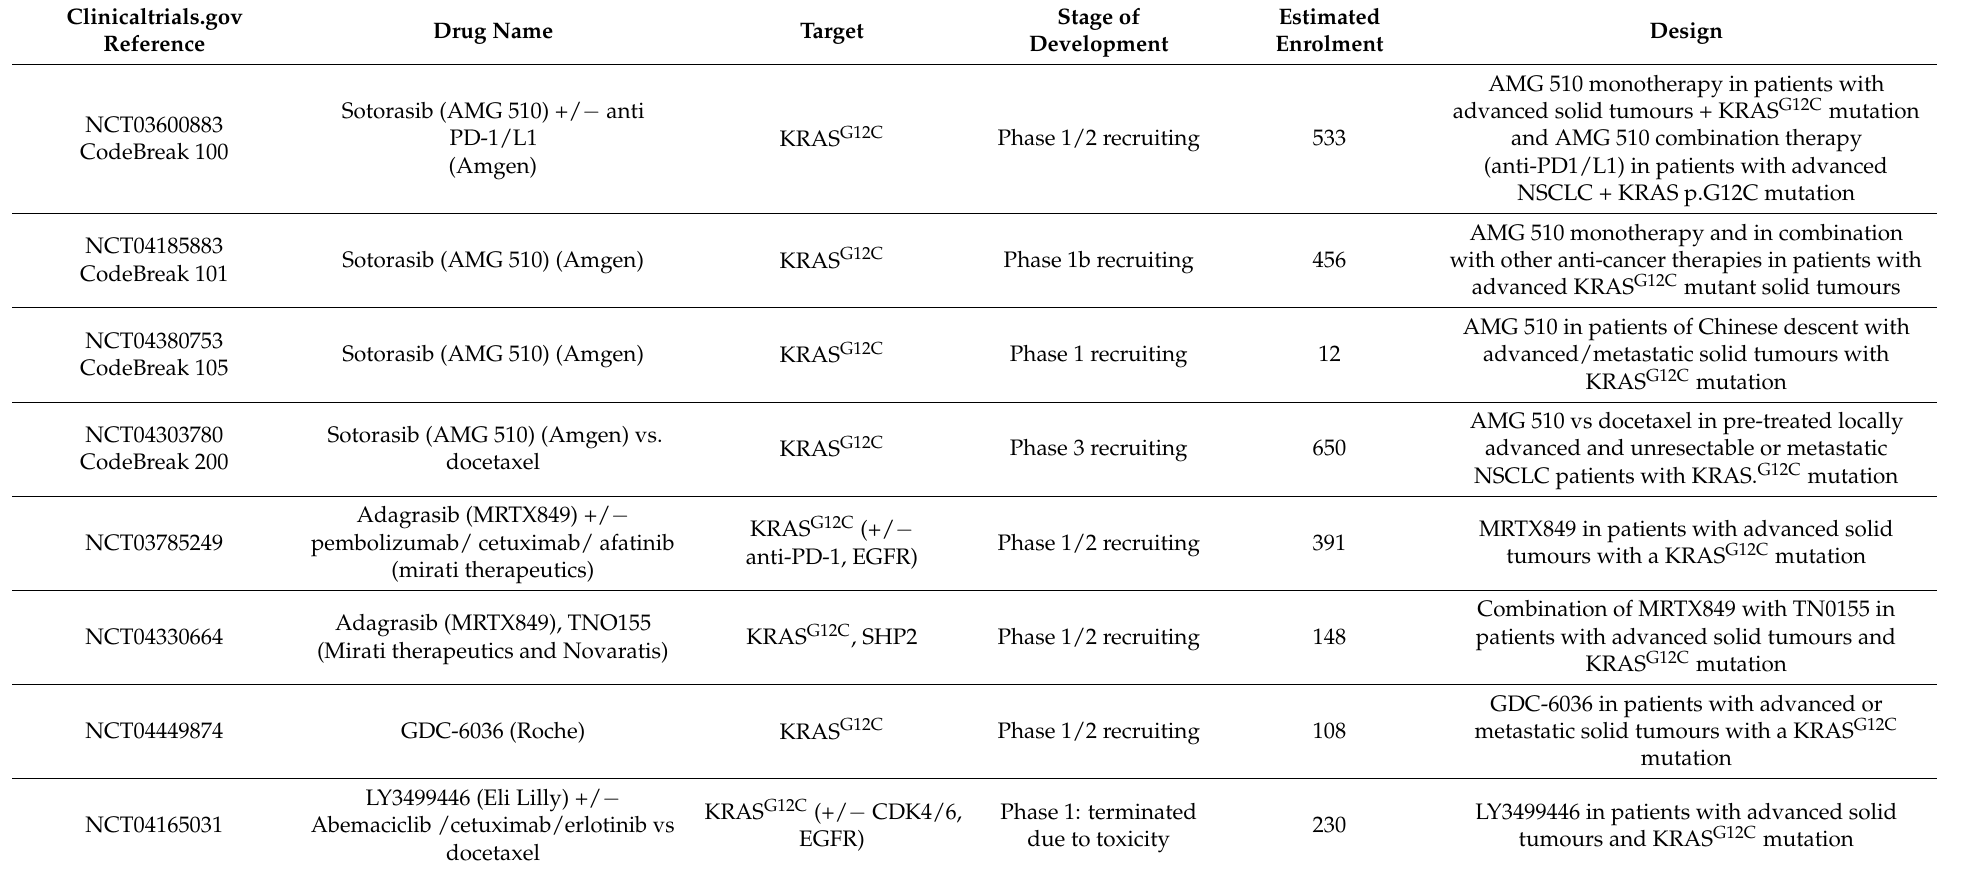
Table 1. Registered trials of G12C inhibitors or SHP2 inhibitors on